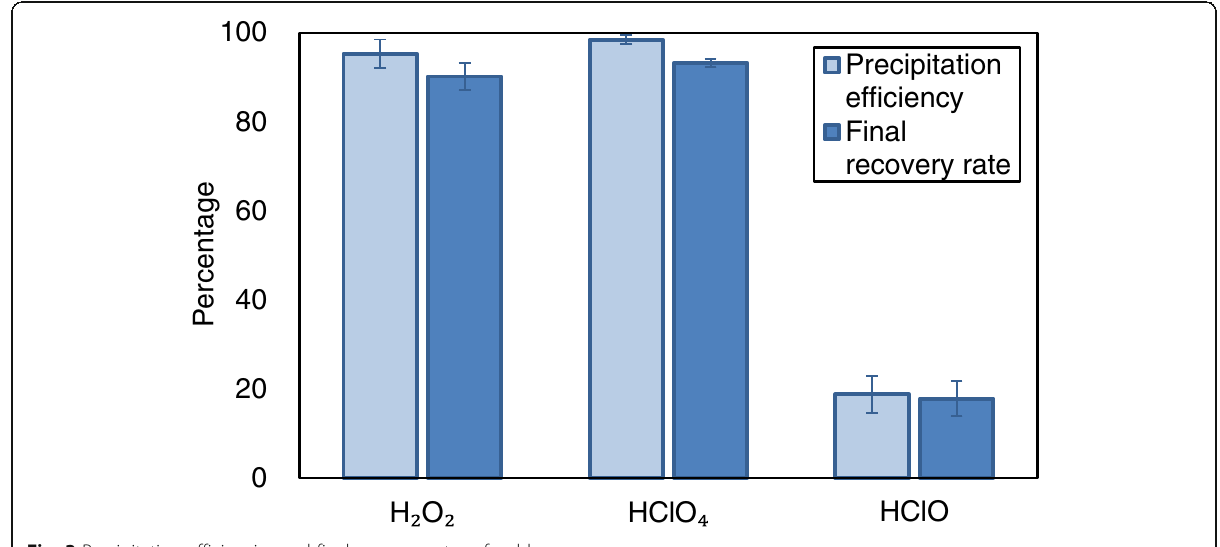
Fig. 3 Precipitation efficiencies and final recovery rates of